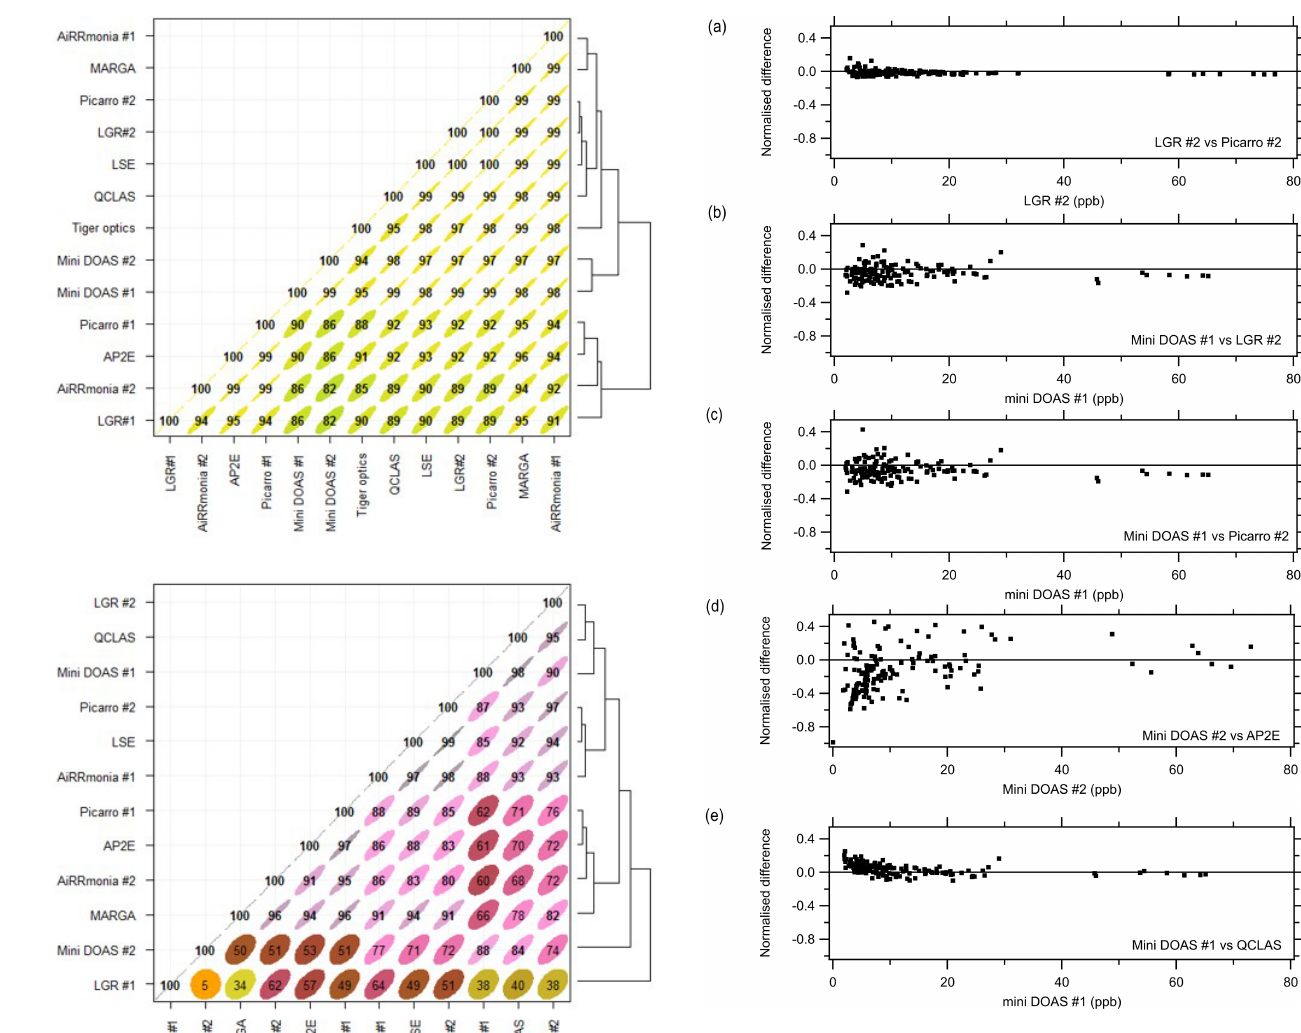
Figure 11. Normalised difference (Eq. 3) between selected instru- ments for the period of 23 August 2016, 00:00, and 29 August 2016, 01:00, based on their hourly